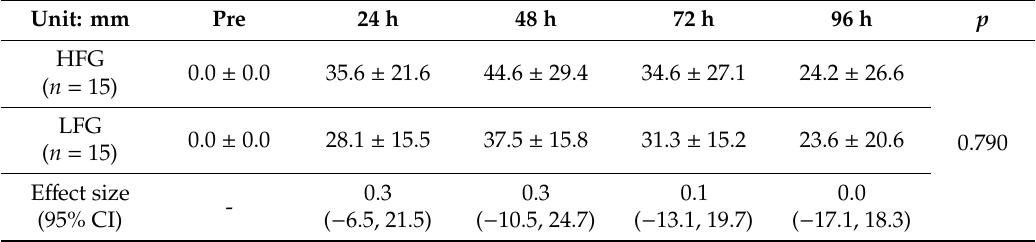
Table 3. Passive muscle soreness following eccentric exercise according to